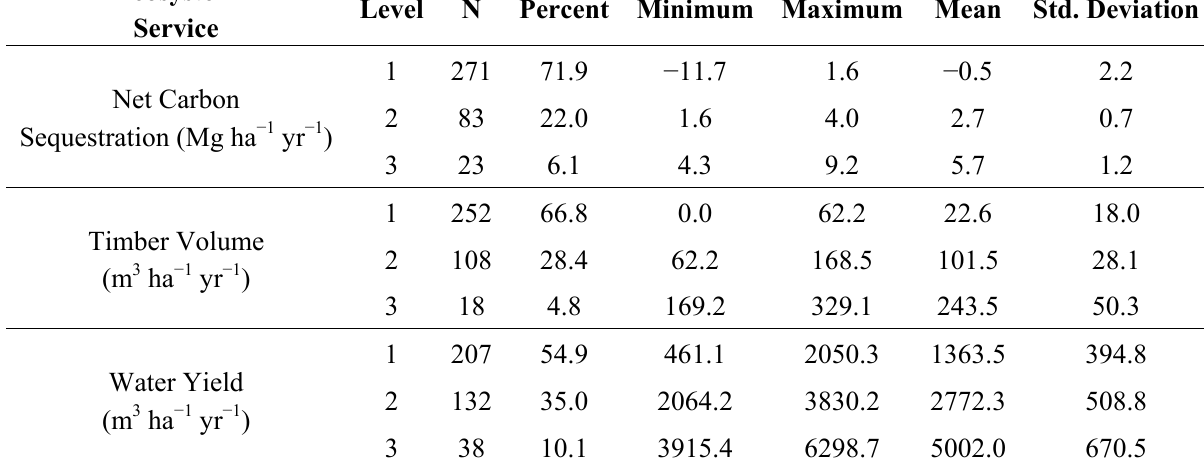
Table 3. Descriptive statistics and categorical levels of provision of each ecosystem service for Florida Pinus elliotti